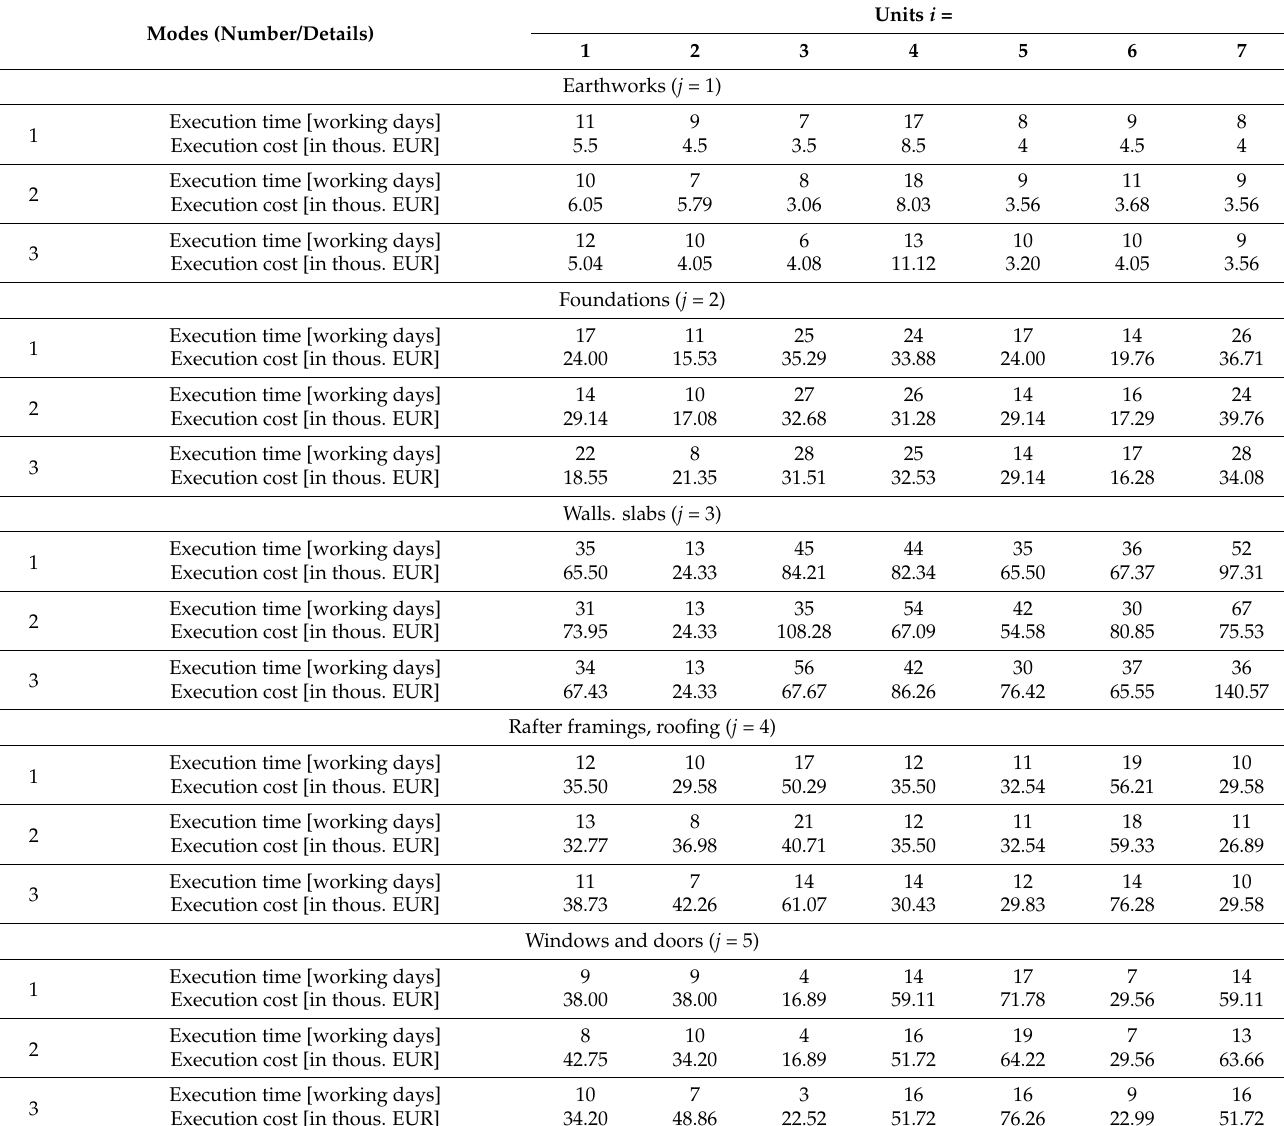
Table 2. The duration of the activities and their cost according to the mode for n = 7 units of a construction